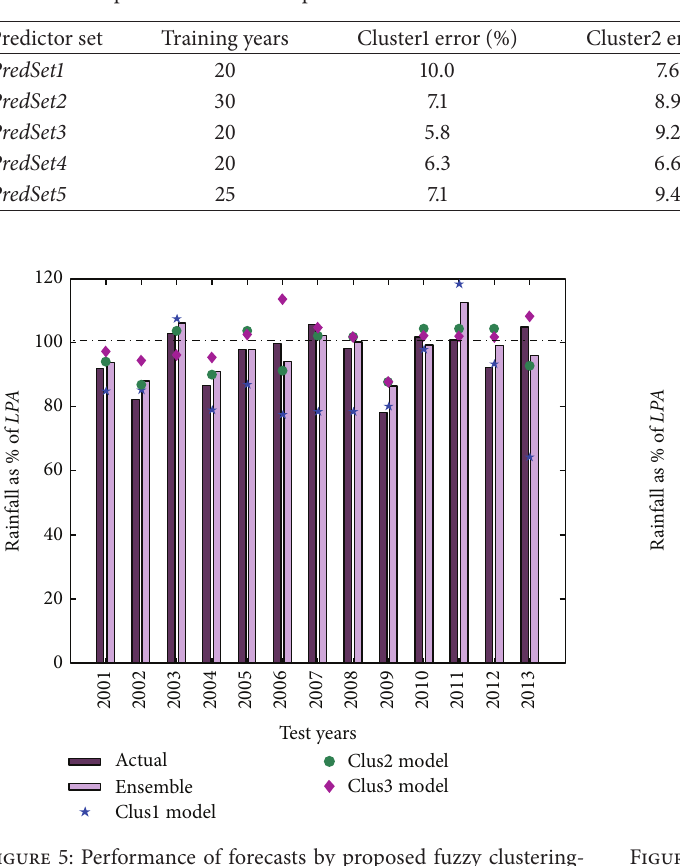
Table 8: Mean absolute errors (%) for annual Indian summer monsoon rainfall prediction by individual GRNN cluster models and ensemble model for test period 2001–2013. Reports minimum error of 6.1 %.